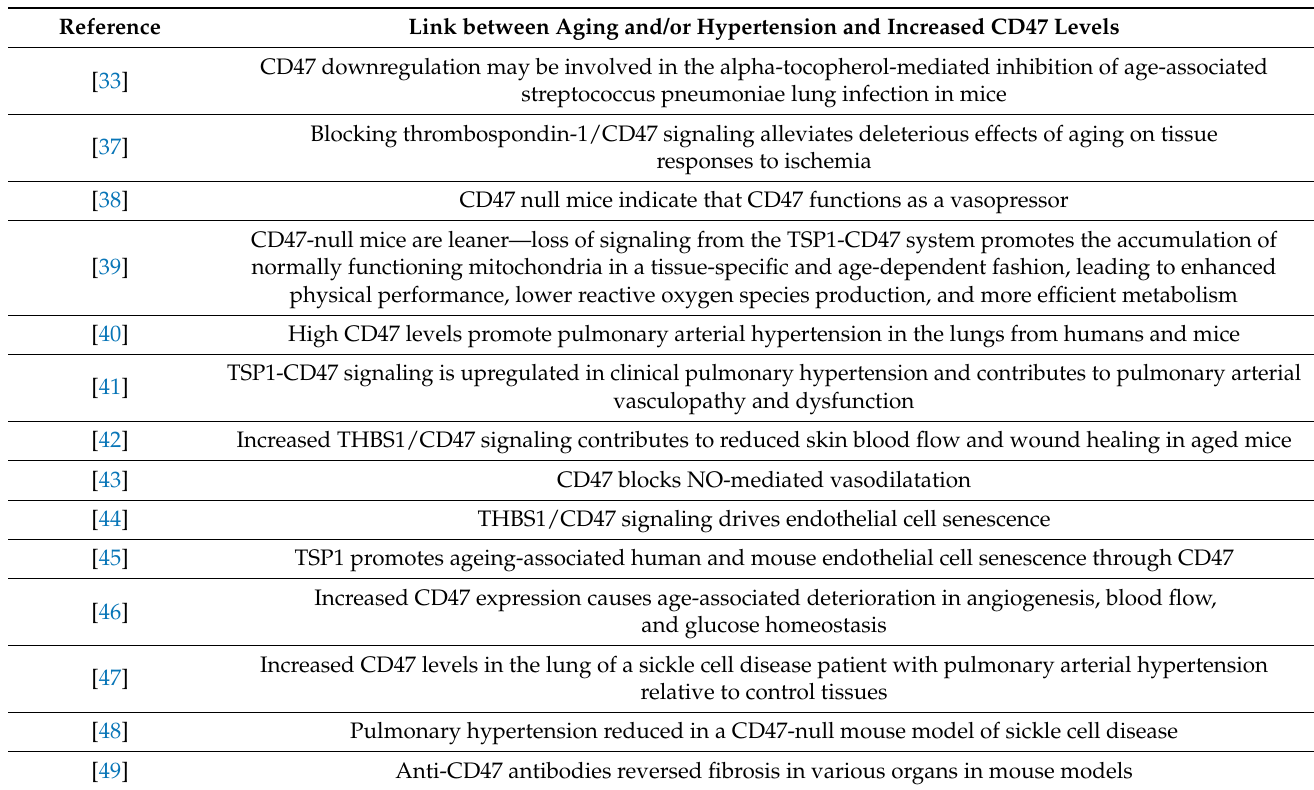
Table 1. Evidence supporting a link between aging and/or hypertension and increased CD47 levels.